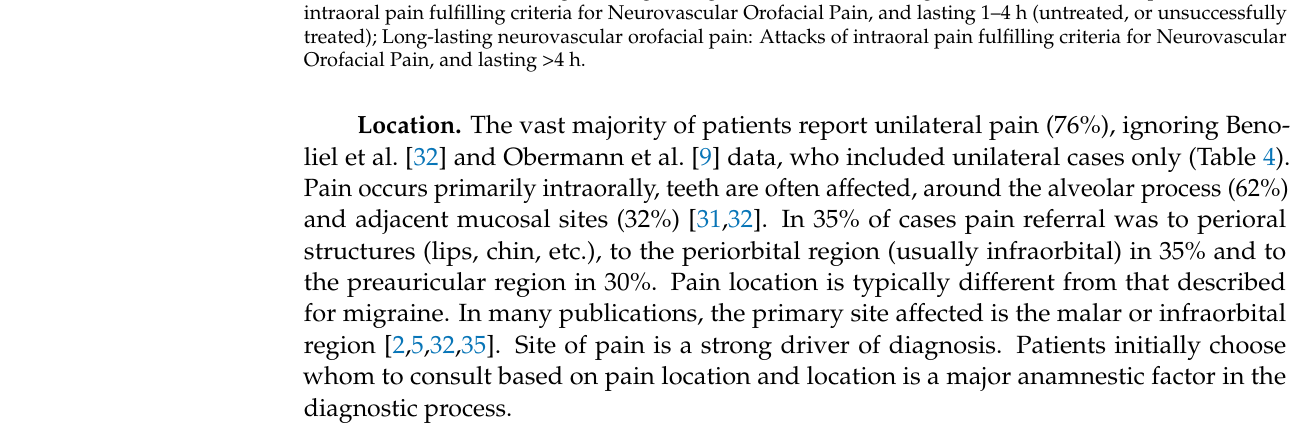
Table 4. Demographics and pain characteristics of NVOP and isolated facial